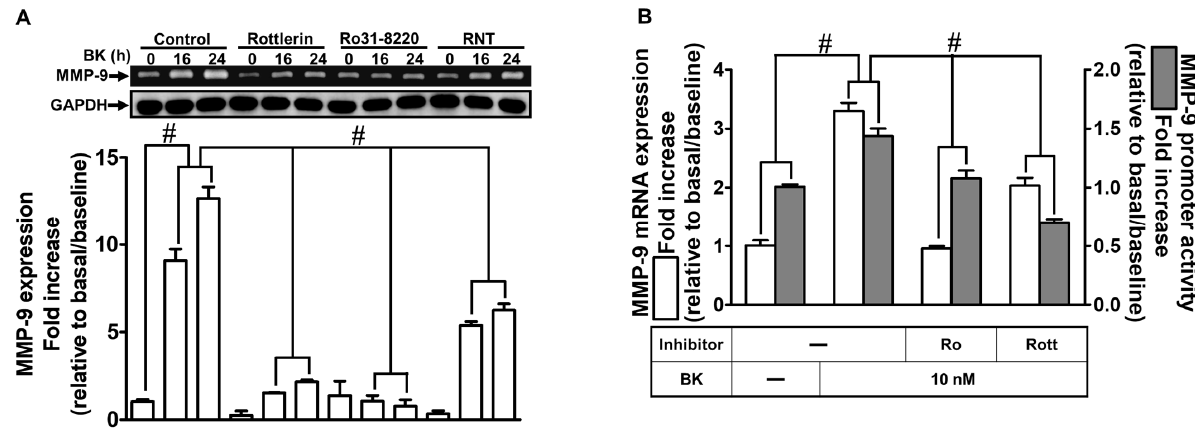
Figure 1. Rhamnetin (RNT) attenuates MMP-9 expression and cell migration induced by bradykinin (BK) in RBA-1 cells. ( A ) The cells were incubated with various concentrations of RNT (3, 10, 30 μ M) for 1 h and then challenged with various doses of BK (10, 100 nM) for 24 h ( a ). The cells were incubated with 10 μ M RNT for 1 h and then challenged with ( b ) 10 nM and ( c ) 100 nM of BK for 2, 4, 8, 16, and 24 h. Media and cell lysates were collected to determine MMP-9 level and GAPDH, by gelatin zymography and Western blot, respectively. ( B ) Cells were pretreated without or with RNT (3, 10, 30 μ M) for 1 h and then incubated with BK (10, 100 nM) for 16 h. The mmp-9 gene expression was determined by real-time PCR. ( C ) Cells were incubated with 10 nM BK for 1, 2, 4, 6, and 8 h (upper panel). Cells were pretreated without or with 10 μ M RNT for 1 h and then incubated with 10 nM BK for 6 h (lower panel). The MMP-9 promoter activity was determined by a luciferase reporter assay. ( D ) Cells were pretreated without or with RNT (10 μ M) for 1 h and then incubated with BK (10 nM) for 48 h. The number of migratory cells was determined (magnification = 40×). Data expressed as mean ± SEM of three independent experiments. # p < 0.01 as compared with the cells exposed to vehicle or BK, as indicated. Abbreviations: BK, bradykinin; RNT, rhamnetin; GAPDH, glyceraldehyde 3-phosphate dehydrogenase.